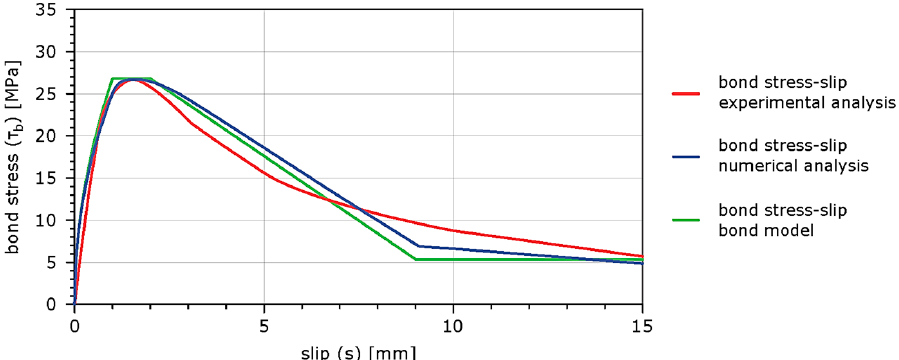
Figure 17. Comparison of bond stress–slip curves for the POT-12 series.